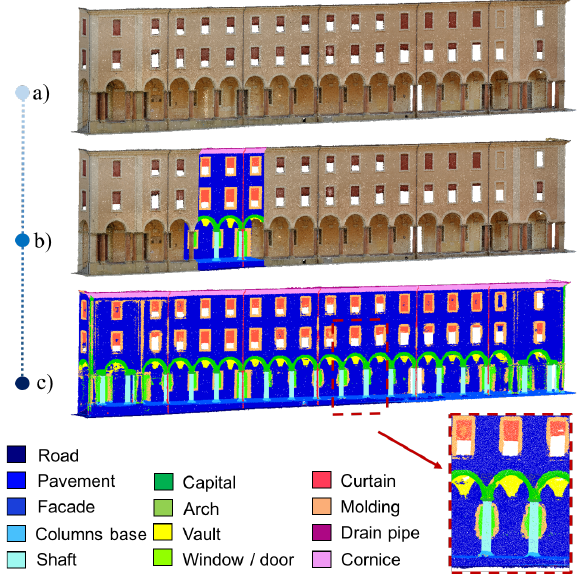
Figure 7. Porticoes point cloud (a), annotated (b) and classified (c).